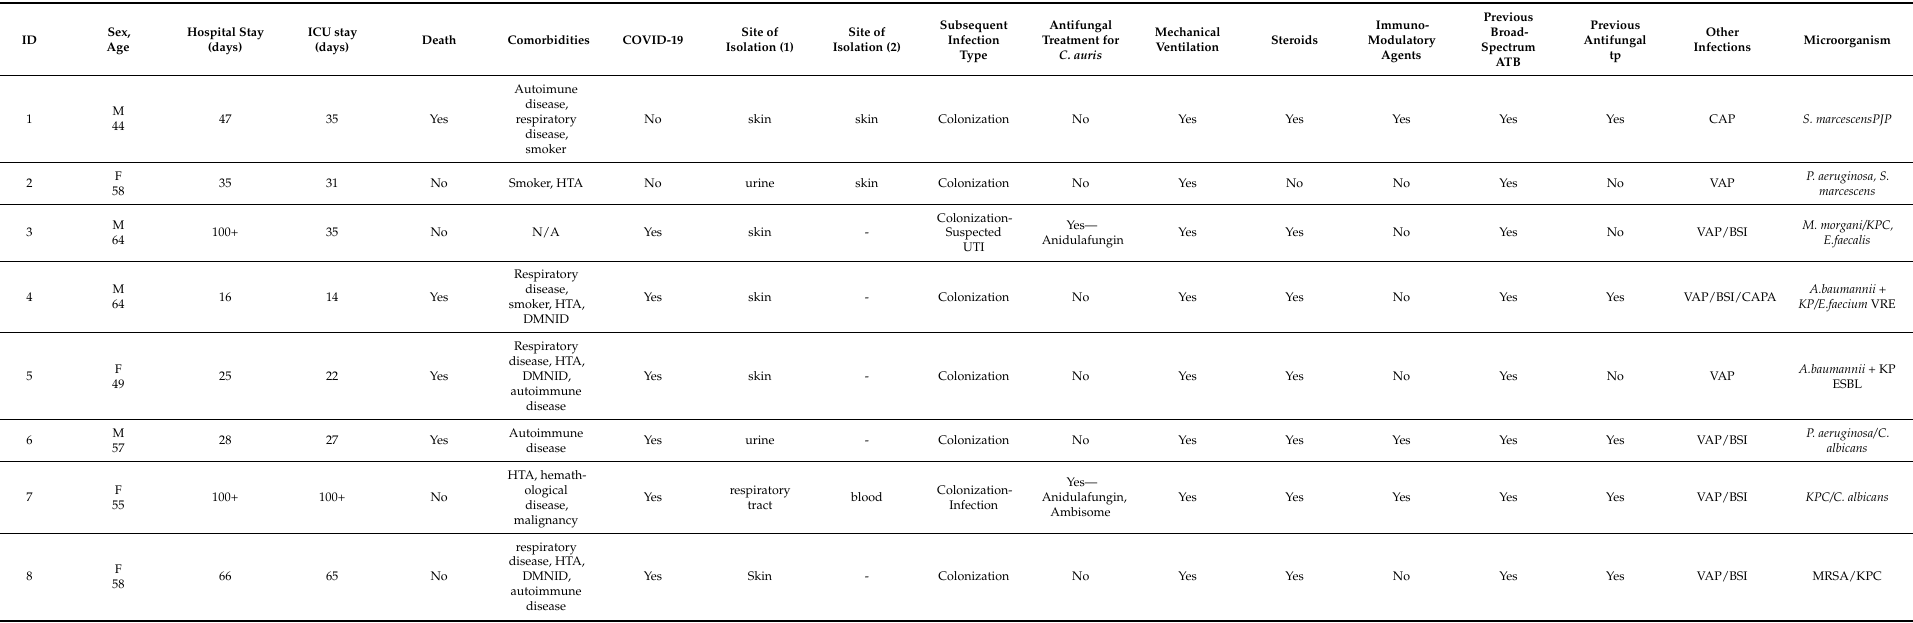
Table 1. Characteristics of C. auris colonized/infected